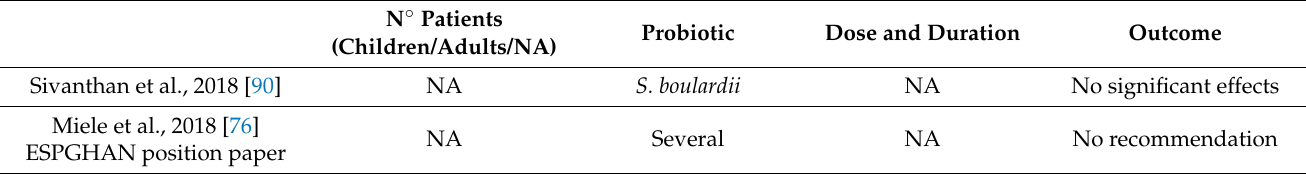
Table 11. Systematic reviews on probiotics in Crohn’s disease.